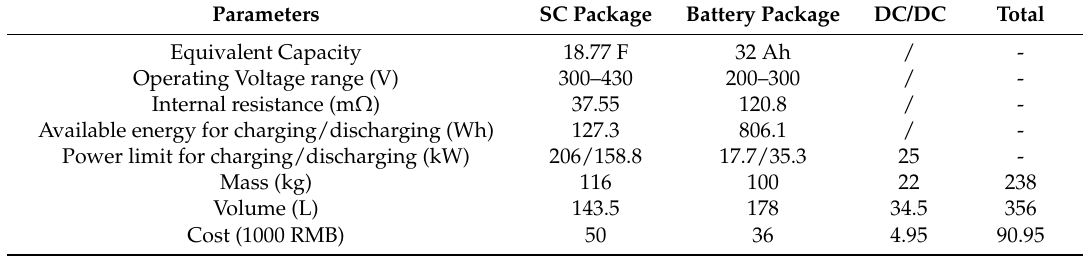
Table 9. Specifications of the SC/battery HESS prototype.